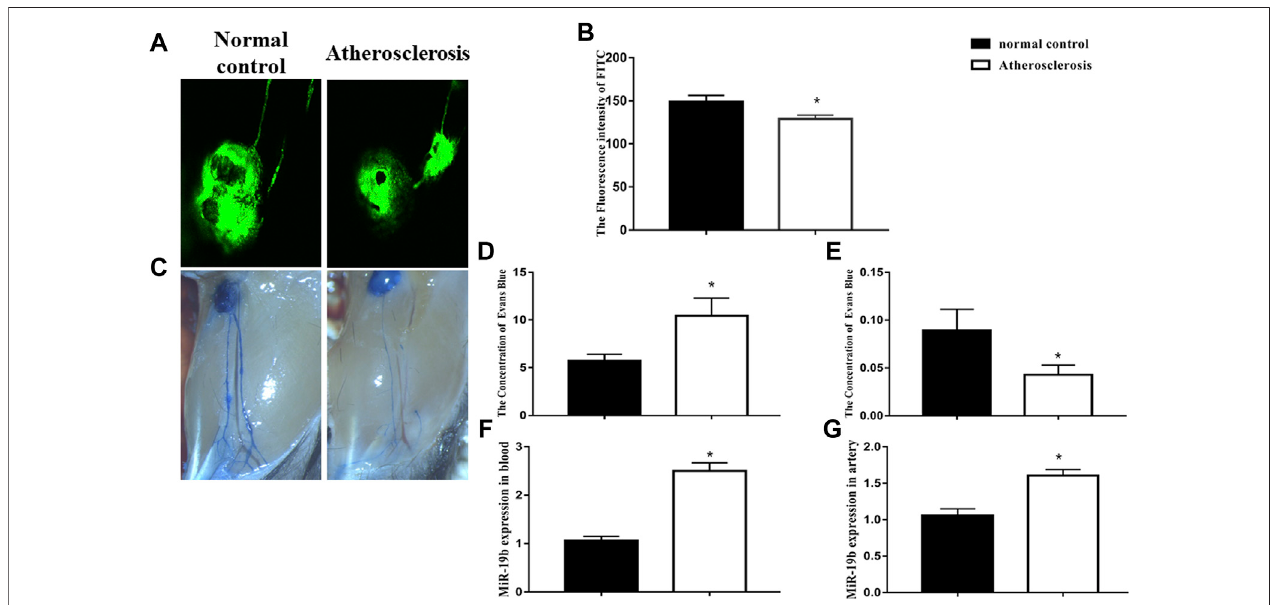
FIGURE1| Lymphaticvessel dysfunctionoccurs intheearlystage ofatherosclerosis. (A) RepresentativeconfocalimageofFITC fl uorescence intensity inpopliteal lymph nodes from normal diet-fed and high-fat diet-fed ApoE -/- mice. (B) Quantitative analysis of the results shown in (A) for the normal control and atherosclerosis groups. * p < 0.05 compared with normal control group, n = 7 per group. (C) Representative Evans blue staining images of lymphatic vessels in legs of normal diet-fed and high-fat diet-fed ApoE -/- mice after 4 weeks of feeding. (D) Amount of Evans blue dye retained in the injected leg lymph node at 10 min after injection. (E) Amount of Evans blue dye retained in opposite leg lymph node at 10 min after injection. * p < 0.05 compared with normal control group, n = 7 per group. (F – G) RT-PCR results for the expression of miRNA-19b in blood and atherosclerotic artery